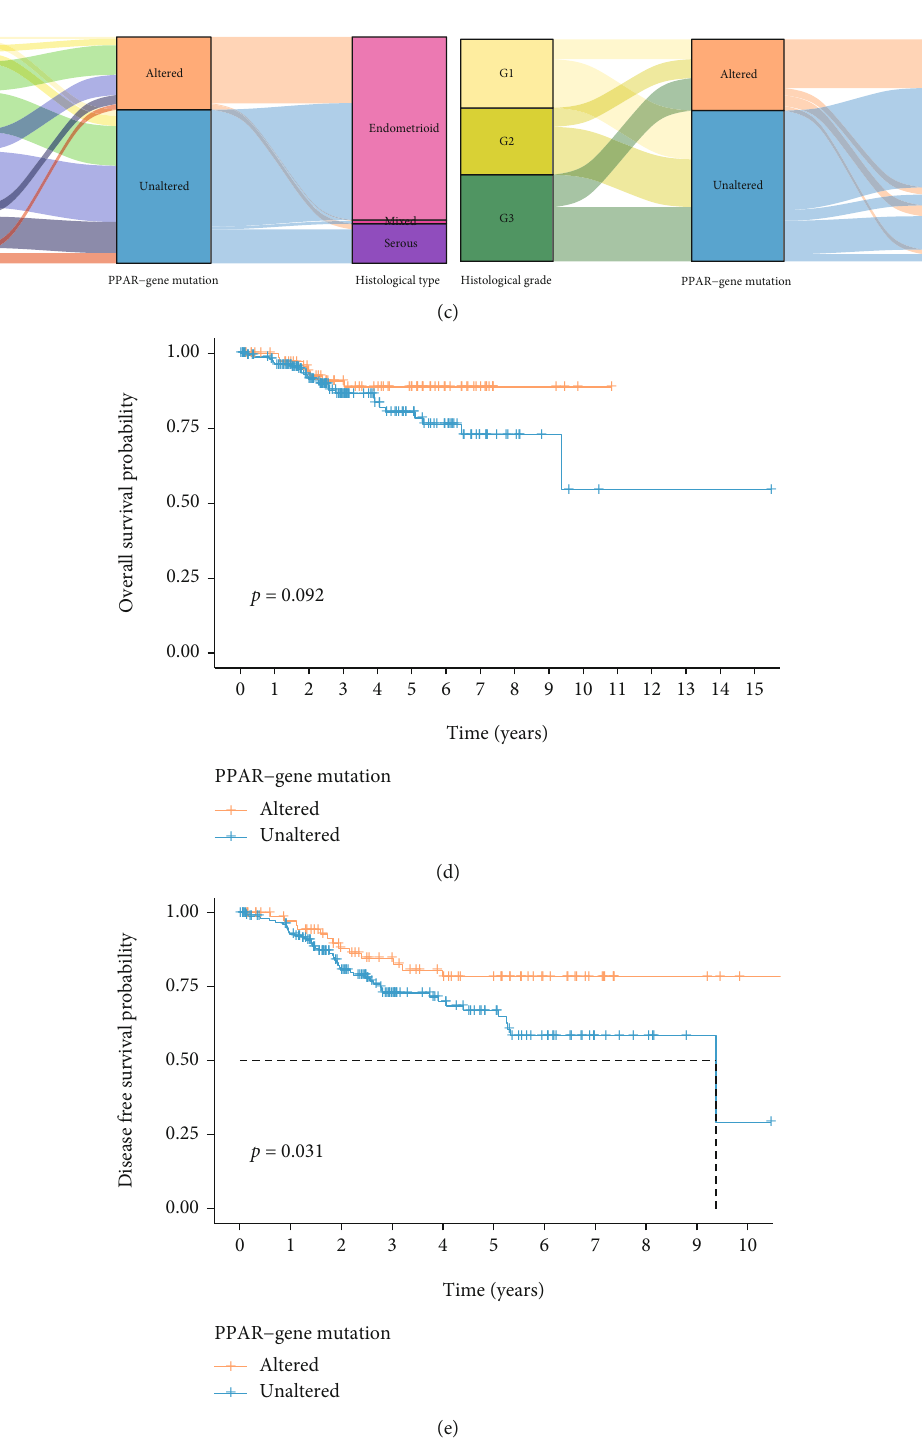
Figure 2: The mutation status of PPAR-related gene and related clinical features in UCEC patients. (a) The frequency of mutation alterations of PPAR-related gene in patients with di ff erent histological type. (b) The mutation type ratio of each PPAR-related gene. (c) Sankey plots shows the clinical information of PPAR-related gene mutated and nonmutated patients. Kaplan-Meier curves show the correlation between PPAR-related gene mutation status and overall survival (d) or disease-free survival (e) probability of UCEC